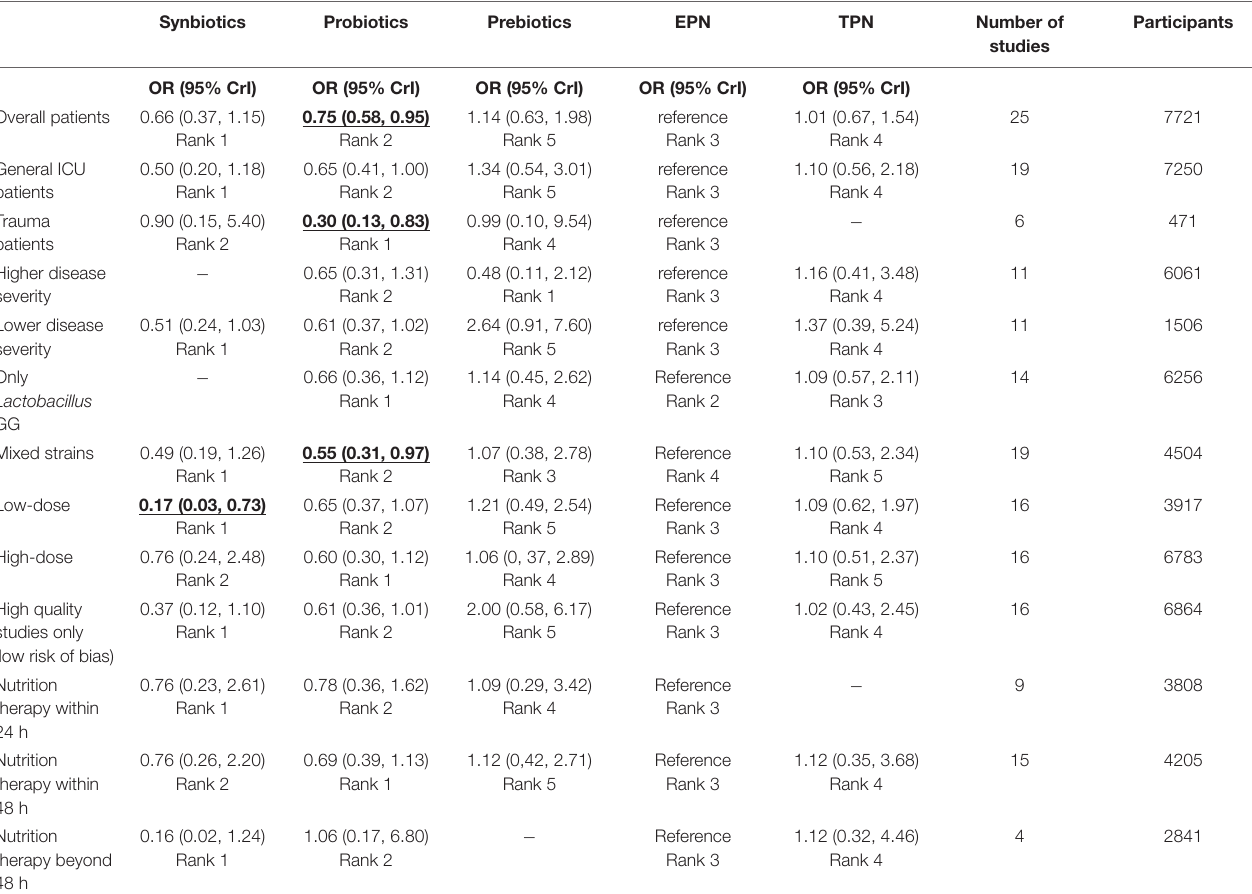
FIGURE 6 | Forest plot of the effect estimate for each active intervention vs. EPN on secondary outcomes. Estimates are presented as odds ratios (OR) or mean difference (MD) and 95% CrI. OR < 1 favor the treatment. MD < 0 favor the treatment. BSIs, bloodstream infections; CrI, credible interval; EPN, enteral nutrition and/or adjuvant peripheral parenteral nutrition; LOS, length of stay; MV, duration of mechanical ventilation; NI, nosocomial infections; TPN, total parenteral nutrition; UTI, urinary tract infection. TABLE 5 | Subgroup analyses for ventilator-associated